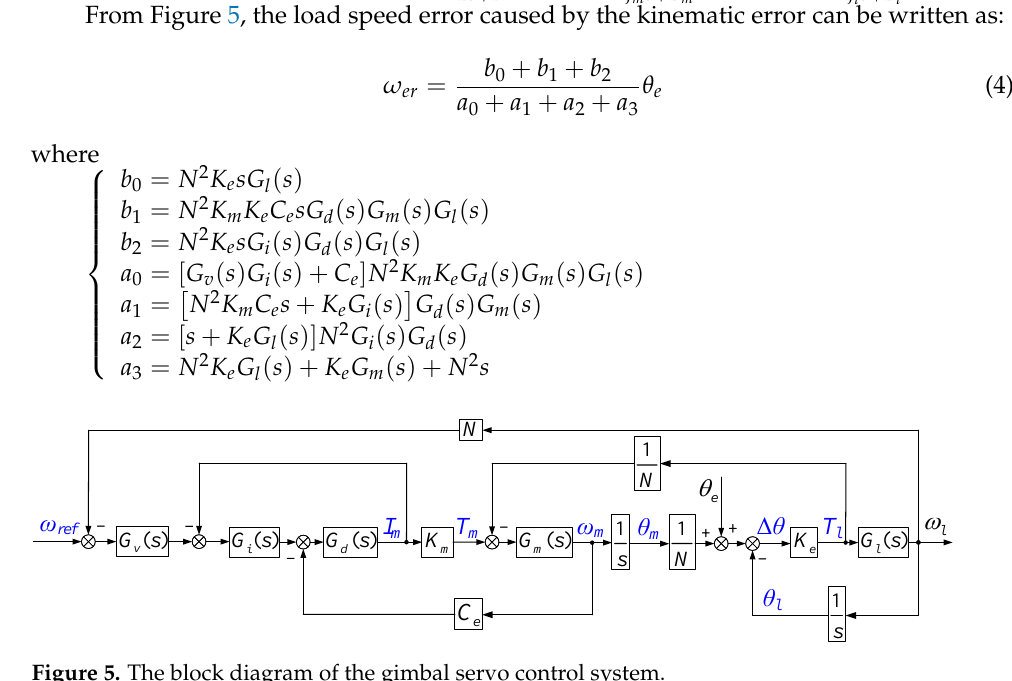
Figure 5. The block diagram of the gimbal servo control